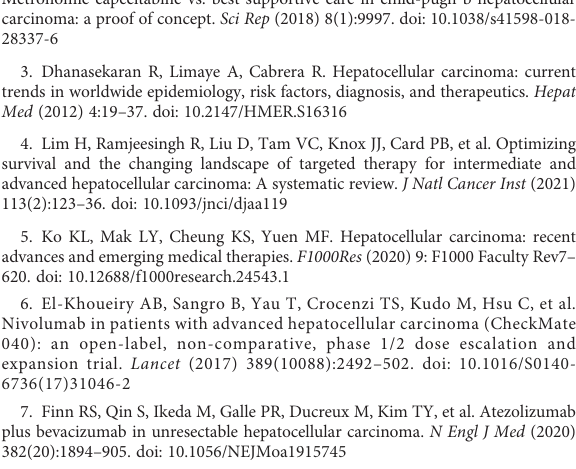
SUPPLEMENTARY FIGURE 1 The median overall survival (A) and median progression-free survival (B) for included studies. SUPPLEMENTARY FIGURE 2 Meta-analysis of the complete response rate (A) and partial response rate (B). OR: odds ratio; CI: con fi dence